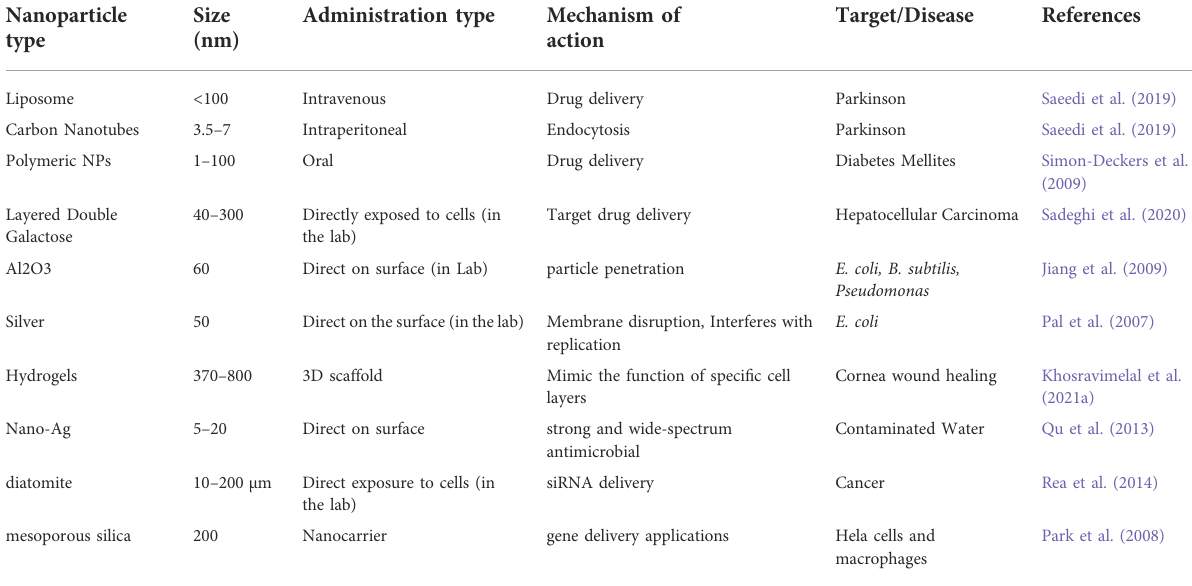
TABLE 2 Some important applications of